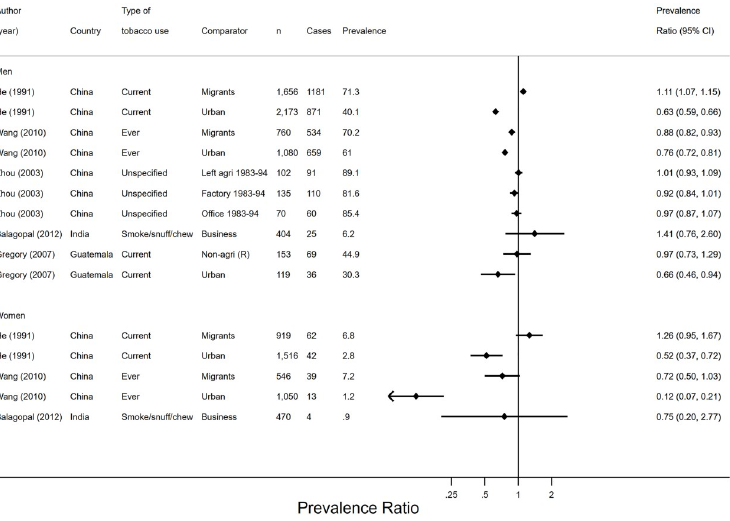
Fig 5. Prevalence ratios and 95% confidence intervals of tobacco use by employment status (n = 5). Agri– agriculture, CI–confidence interval, n–sample size, PR–prevalence ratio, R–rural. Prevalence ratios were derived from comparing each non-agricultural group (coded 1) to the agricultural group (coded